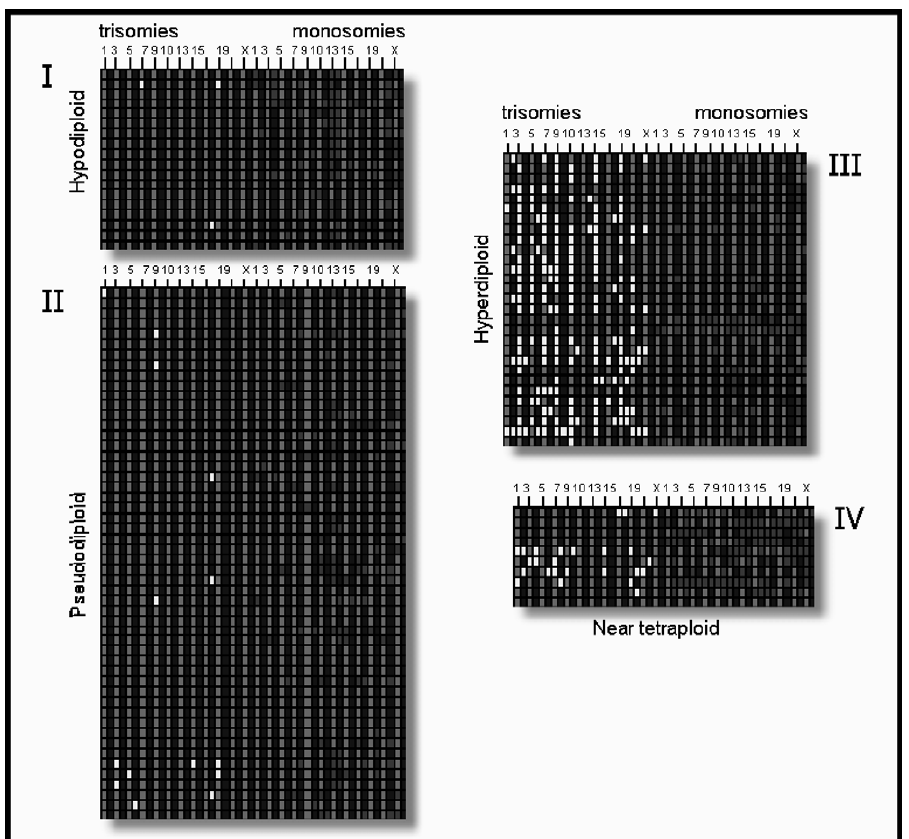
Figure 1 should be placed at the end of Section 2: Genomic status of cancer cells;